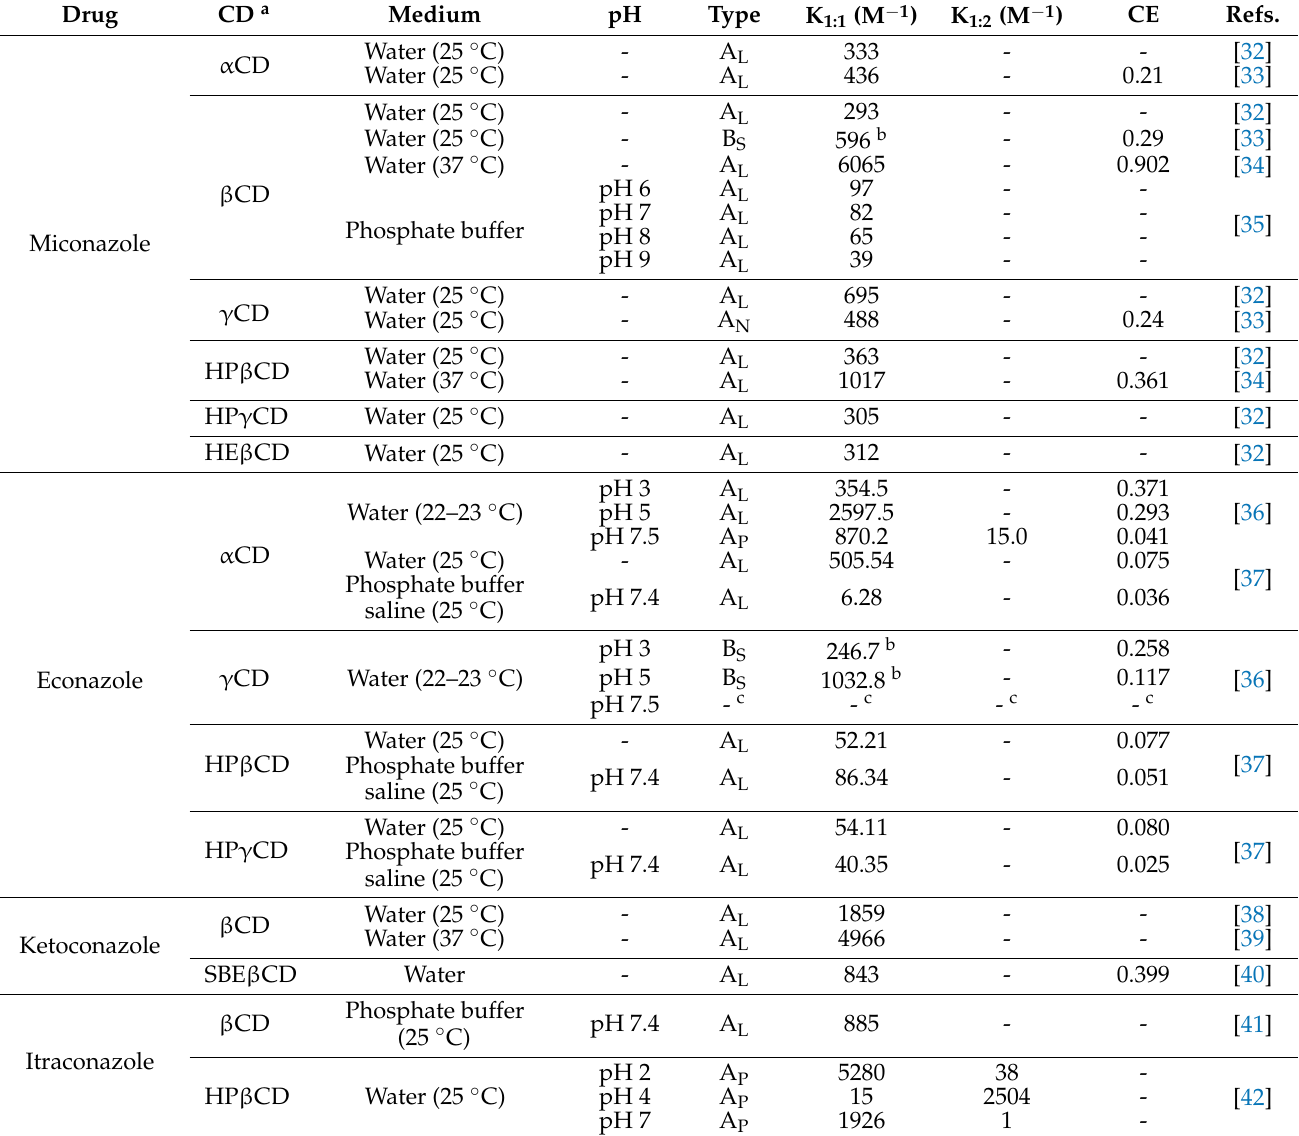
Table 2. Summarized data of the stability constant (K 1:1 and K 1:2 ) and complexation efficiency (CE) values of antifungal/CD